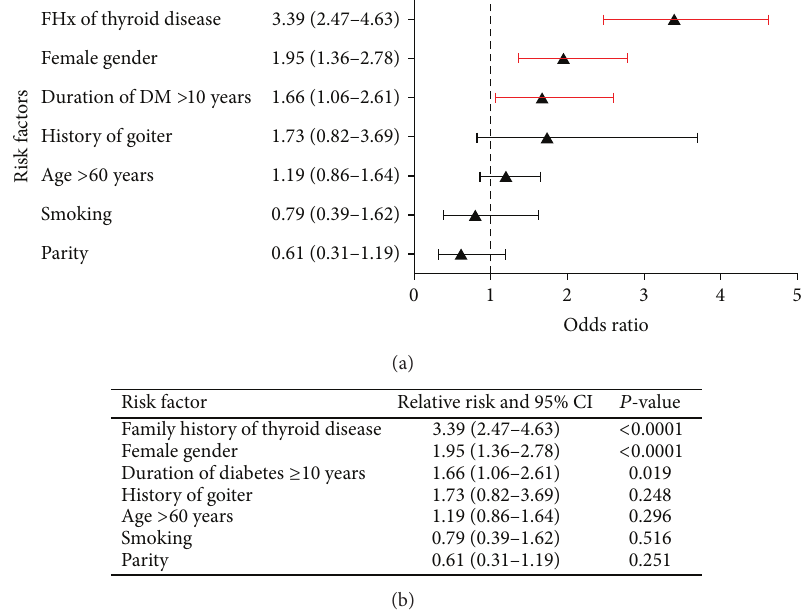
Figure 2: Relative risks for thyroid dysfunction among Type 2 Saudi diabetic patients; (a) forest plot, (b) table of